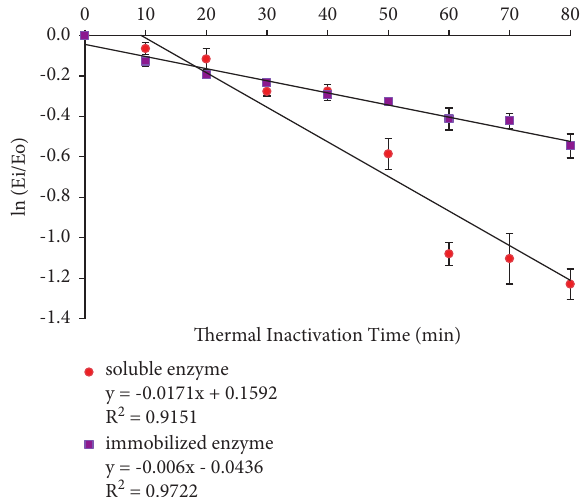
Figure 7: First-order inactivation rate plot of soluble and immobilized enzymes. The data are presented as mean ± SD; n � 2; a significant difference � p < 0 . 05. The error bars represent standard deviations from two replicates Table 3: k i , Δ G i , and t 1/2 values for soluble and immobilized enzymes. The values are shown as mean ± SD, n Sample k i (min − 1 ) t 1/2 (min) Δ G i (kJ mole − 1 ) Soluble enzyme Immobilized enzyme